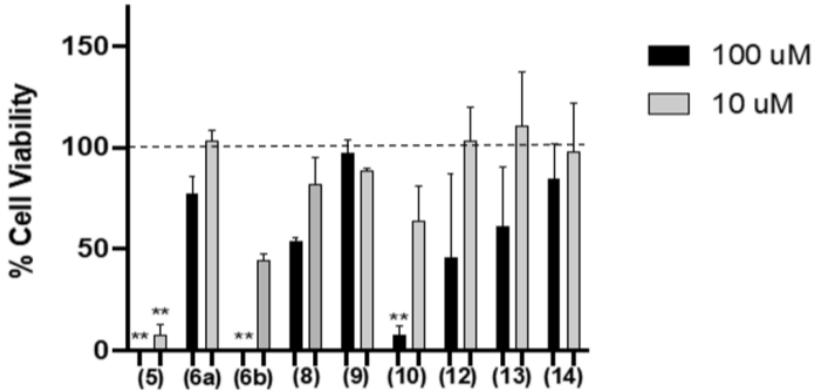
Figure 2. HeLa cell viability studies. Cells were treated with either a DMSO control (dashed line) or the synthesized compounds at a concentration of 100 µM (black bars) or 10 µM (grey bars).